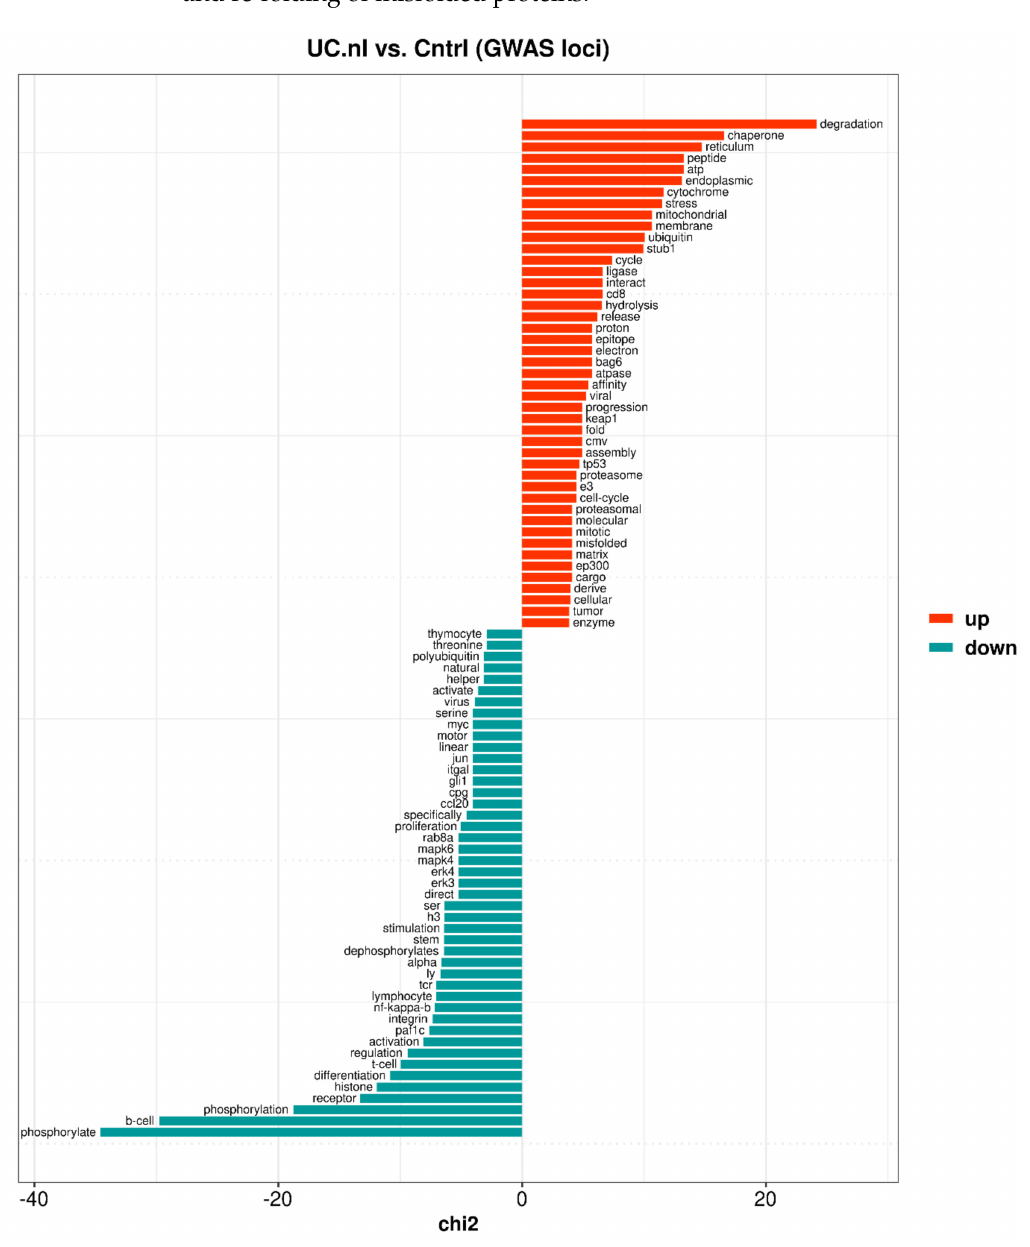
Figure 5. Top 45 keyness words describing a preferential association of unigrams with either upreg- ulated (orange bars) or downregulated (blue-green bars) genome-wide association study (GWAS)- related genes of the non-inflamed UC mucosa (UC.nI) compared to control mucosa (Cntrl). Keyness words were based on statistical text analysis of functional protein information (UniProtKB) associated with the GWAS-related genes. The chi2 value on the x -axis is the test statistic obtained from the Chi-square test used to calculate